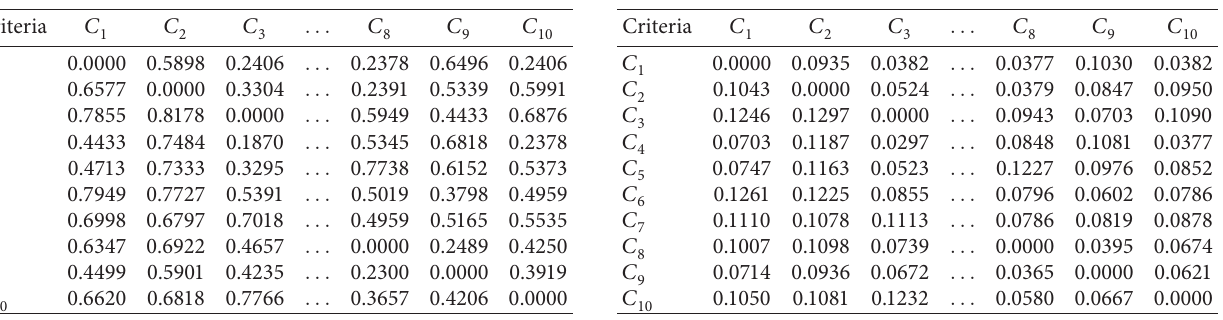
Table 9: Normalised